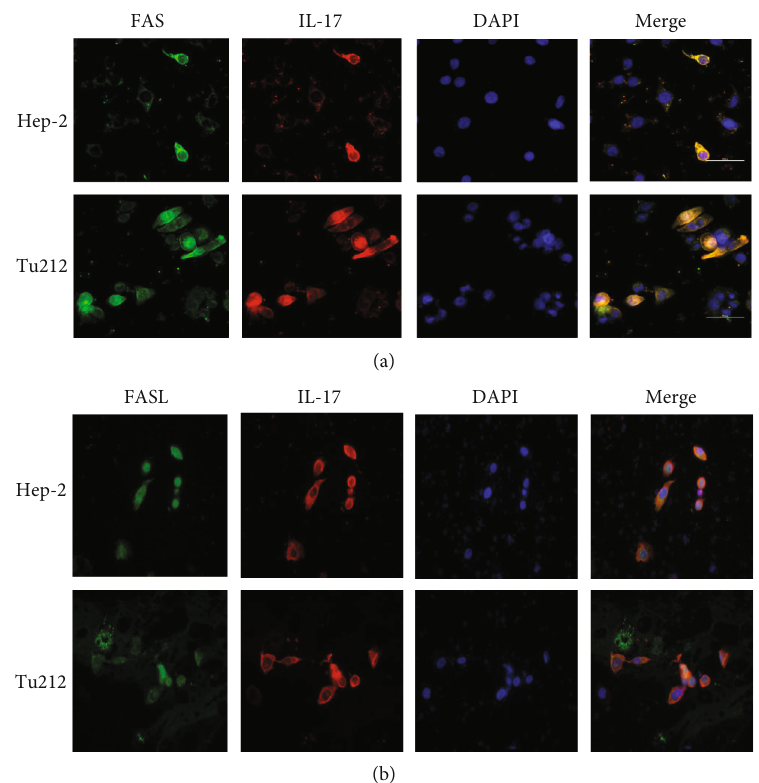
Figure 3: IL-17 colocalized with FAS/FASL in laryngeal carcinoma cells in vitro . (a) LC cells were exposed to 50 ng/mL of 200-17 for 6h and were immunostained with antibodies against FAS (red) and DAPI (blue), followed by confocal microscopy. (b) LC cells were exposed to 50ng/mL of 200-17 for 6h, and then they were immunostained with antibodies against FASL (red) and DAPI (blue), followed by confocal